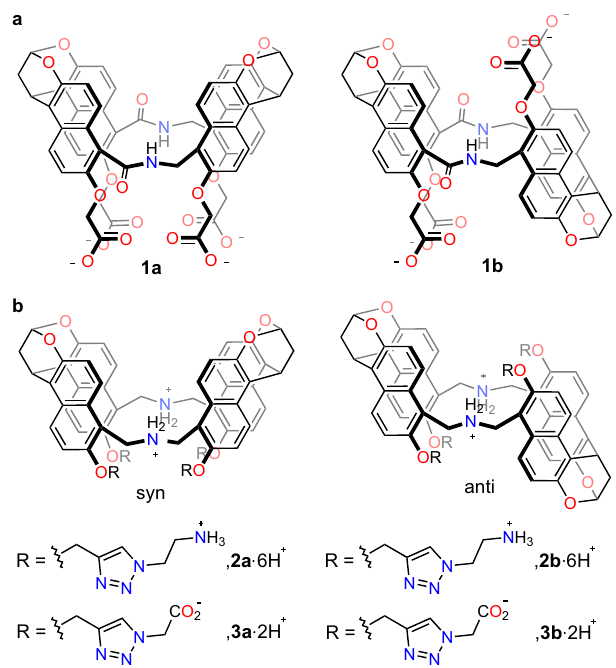
Fig. 1 Chemical structures of the amide and amine naphthotubes. a Amide naphthotubes ( 1 ). b Amine naphthotubes ( 2 and 3 ) with the secondary ammonium groups in the